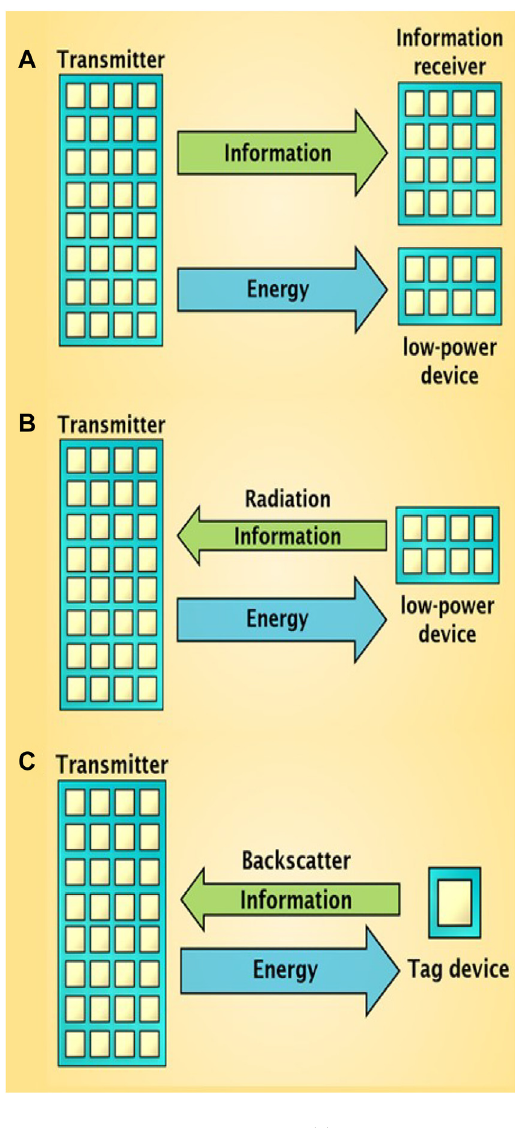
Figure 2: Different SWIPT systems. (A) Wireless power communication system. (B) Wireless power radiation communication system. (C) Wireless power backscatter communication